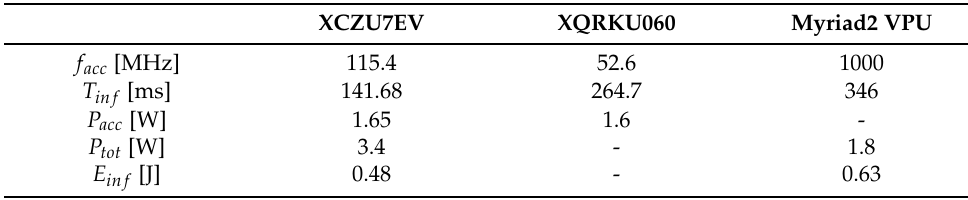
Table 8. Results summary for XCZU7EV, XQRKU060, and Myriad-2